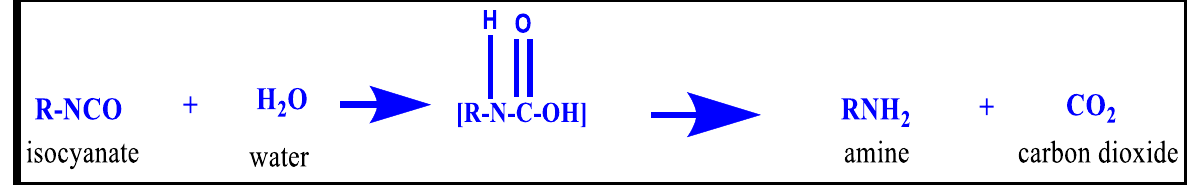
Figure 9. Reaction of Isocyanate with water [109].